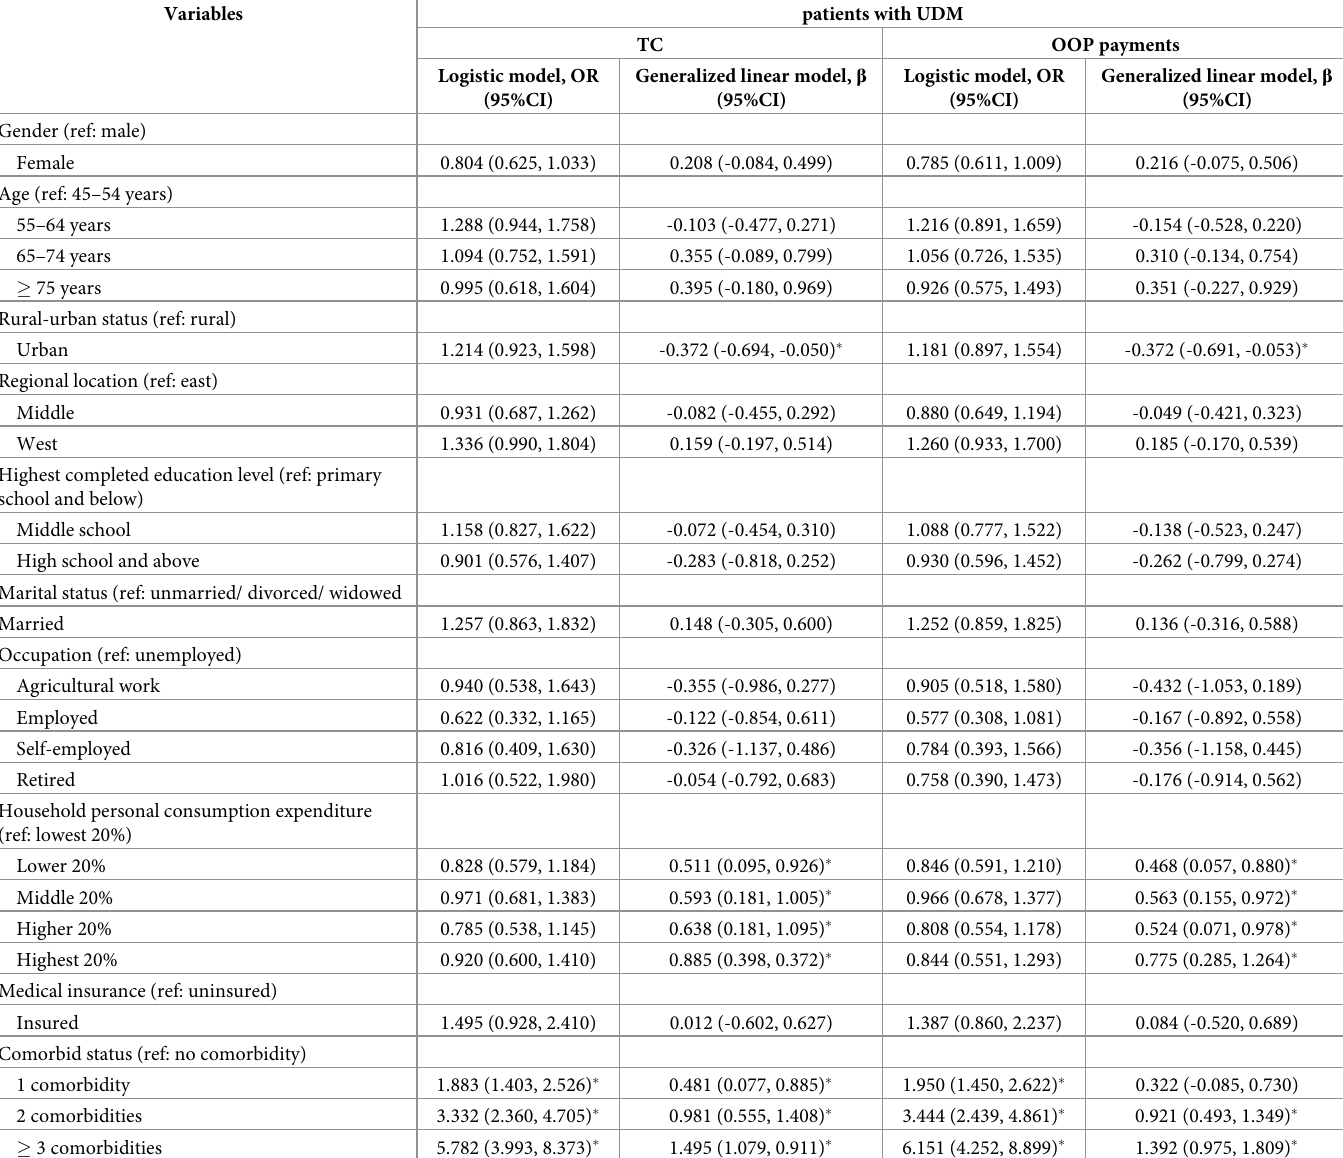
Table 5. Association between social determinants and TC and OOP in the population with UDM in CHARLS 2011 study.